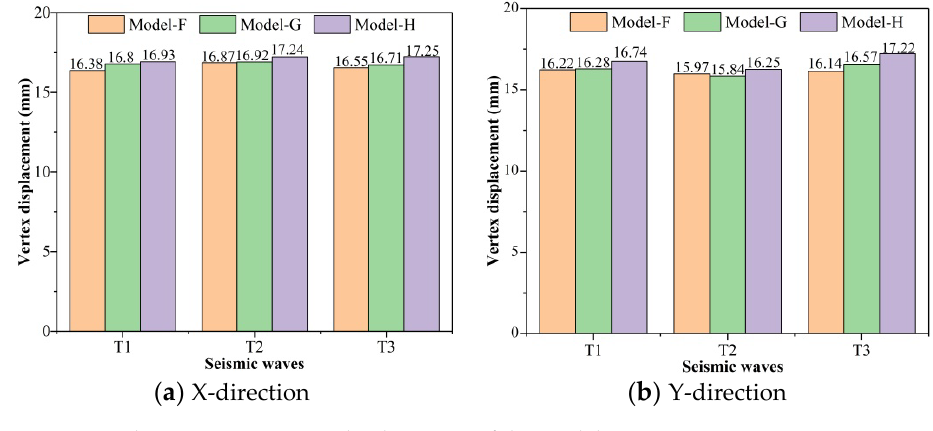
Figure 21. The maximum vertex displacement of the models.